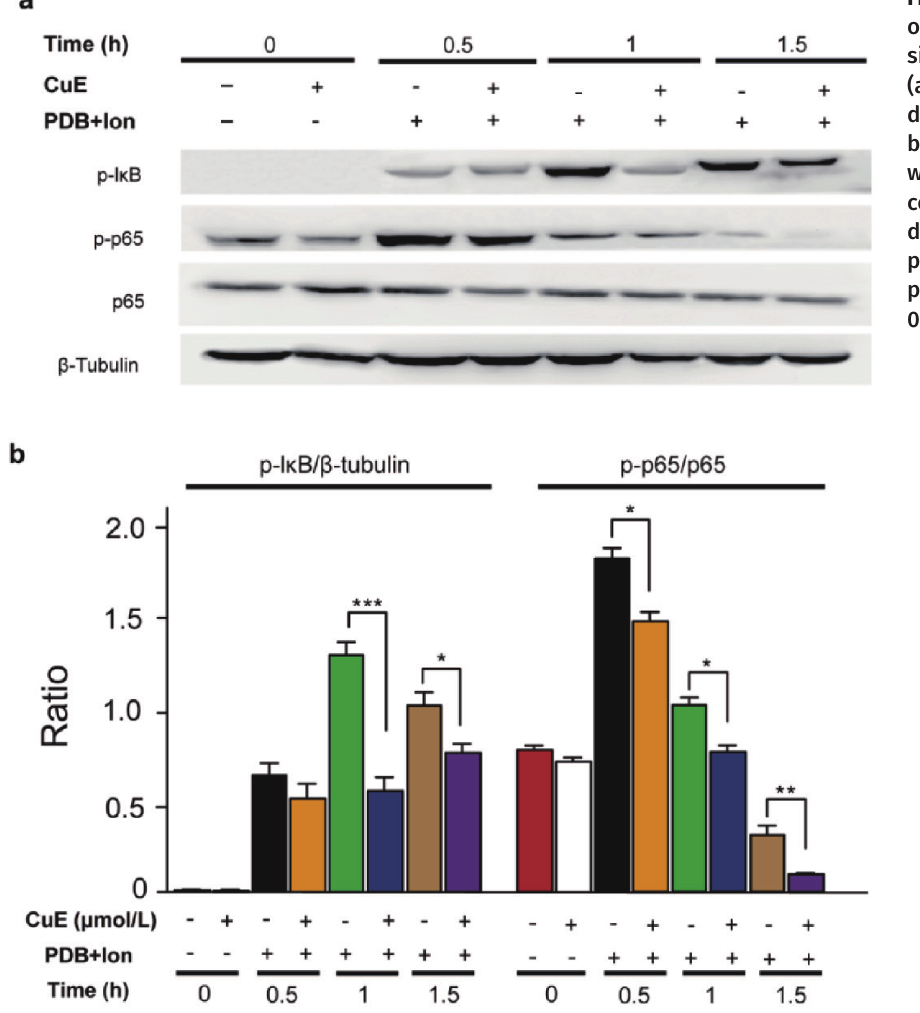
Figure 8. Inhibitory effect of CucE on the NF-κB signaling in Jurkat T cells. (a) Protein levels were determined by Western blotting. β-Tubulin was used as a loading control. (b) The relative densitometric ratios of p-lκB to β-tubulin or p-p65/p65. * P < 0.05, ** P < 0.02, *** P <